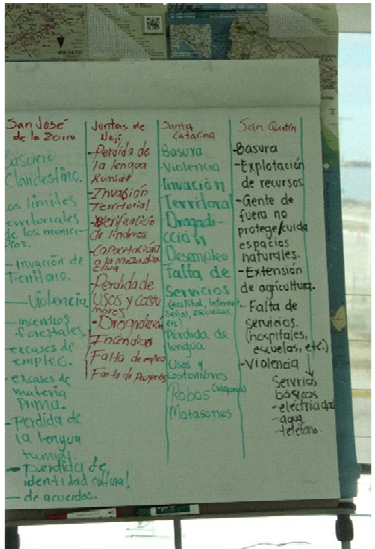
Figure 4. Nunaliit workshop. Enumeration of the problems of the region. Credits: Martín Cuitzeo Domínguez Núñez.